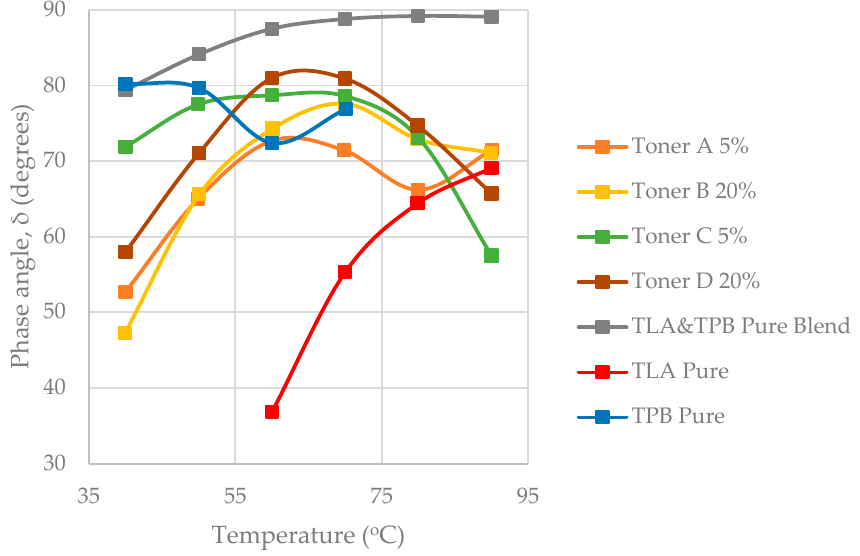
Figure 7. The effect of temperature on the complex shear modulus (G*) of the various optimized toner blends, unmodified TLA/TPB paving binder, and pure TLA and TPB.